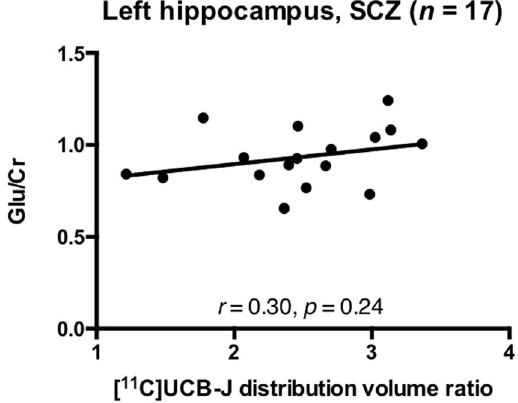
Fig. 2 Synaptic density and glutamate in patients with schizo- phrenia. No signi fi cant relationship between [ 11 C]UCB-J distribution volume ratio and Glu/Cr levels in the ACC in the schizophrenia (SCZ) group. ACC = anterior cingulate cortex.